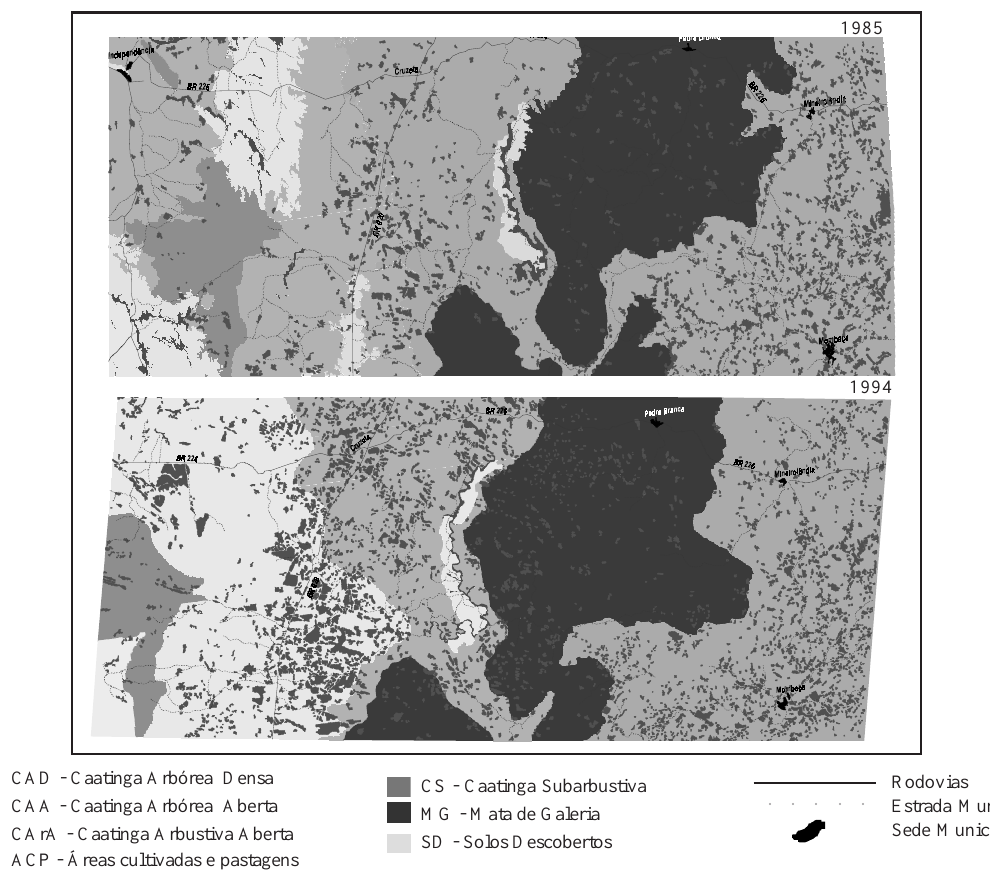
Figura 2. Sobreposição das cartas de vegetação e áreas cultivadas e pastagens (interpretação a partir da imagem Landsat TM-5, WRS 217/064A; passagens em 20 de julho de 1985 e 14 de agosto de